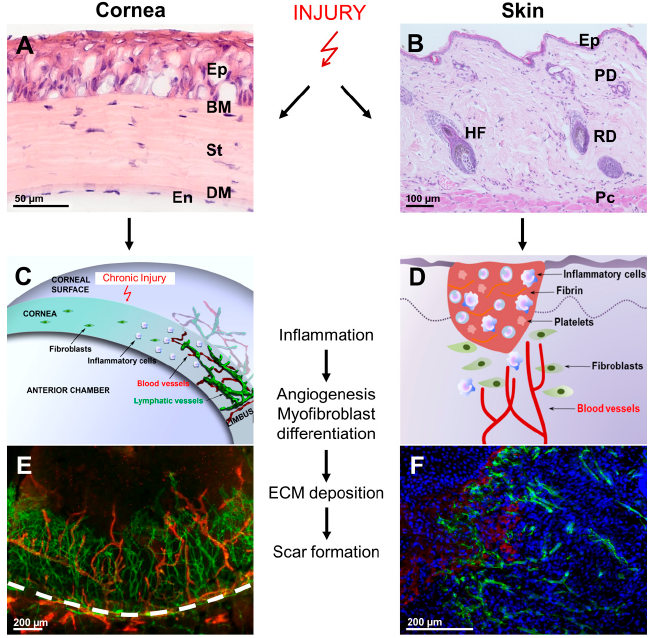
Figure 1. Parallels and differences in corneal and skin wound healing. Injury and wound healing in cornea and skin involves a similar sequence of events: inflammation, myofibroblast differentiation, extracellular matrix (ECM) deposition and eventually development of fibrosis. Yet, specific cellular responses, such as immediate keratocyte apoptosis after wounding, are unique events in corneal wound healing and presumably serve to avoid excessive corneal inflammatory reactions and opacification after tissue injury. Due to the physiological avascular nature of the cornea, hemostasis and activation of platelets are absent in corneal healing; however, both processes provide an important source of growth factors and cytokines in skin wound healing. Instead, in cornea, several of these factors (e.g., platelet-derived growth factor (PDGF)) are provided by epithelial cells [17]. Furthermore, to maintain its transparency, the cornea does not respond with the induction of capillary sprouts to minor injuries, which is essential to maintain good vision; however, chronic injury leads to an angiogenic response. ( A ) Histological view of the unwounded mouse cornea (HE staining); Ep: epithelium; BM: Bowman layer; St: stroma; DM: Descemet’s membrane; En: endothelium; ( B ) Histological view of the unwounded mouse skin (HE staining); EP: epidermis; PD: papillary dermis; RD: reticular dermis; Pc: panniculus carnosus; HF: hair follicle; ( C ) Infiltration of inflammatory cells into the physiologically avascular cornea and sprouting of blood and lymphatic vessels from the limbus after severe corneal injury (modified from Hos et al. [18]). Of note, corneal angiogenesis is a rare event and usually does not occur during wound healing. However, in severe and eye-threatening conditions, proangiogenic stimuli might overcome the corneal antiangiogenic mechanisms and lead to the secondary ingrowth of pathological vessels from the limbus into the corneal center. This is in contrast to skin wound healing, where capillary sprouts are important for an adequate healing response; ( D ) In skin wound healing, hemostasis, platelet activation and angiogenesis are key repair mechanisms. Similar to corneal wound healing, skin repair involves immune cell recruitment, activation and transdifferentiation of fibroblasts, which synthesize and remodel extracellular matrix and mediate wound contraction; ( E ) Murine corneal whole mount after experimentally-induced corneal injury and neovascularization (green: blood vessels, CD31 stain; red: lymphatic vessels, lymphatic vessel endothelial hyaluronan receptor 1 (LYVE-1) stain); the dashed white line indicates the limbal border. ( F ) Skin wound three days post-injury; immunohistochemical double staining for fibrin and blood vessels (blue: DAPI stain; red: fibrin stain; green: blood vessels, CD31 stain).